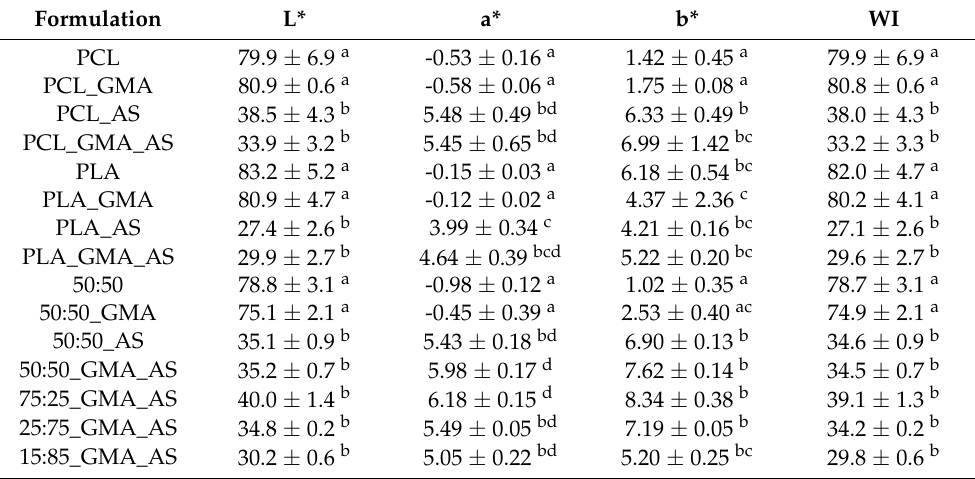
Figure 1. Visual appearance of the obtained biocomposites. Table 2. Color parameters obtained for biocomposites. Mean ± SD ( n = 3).